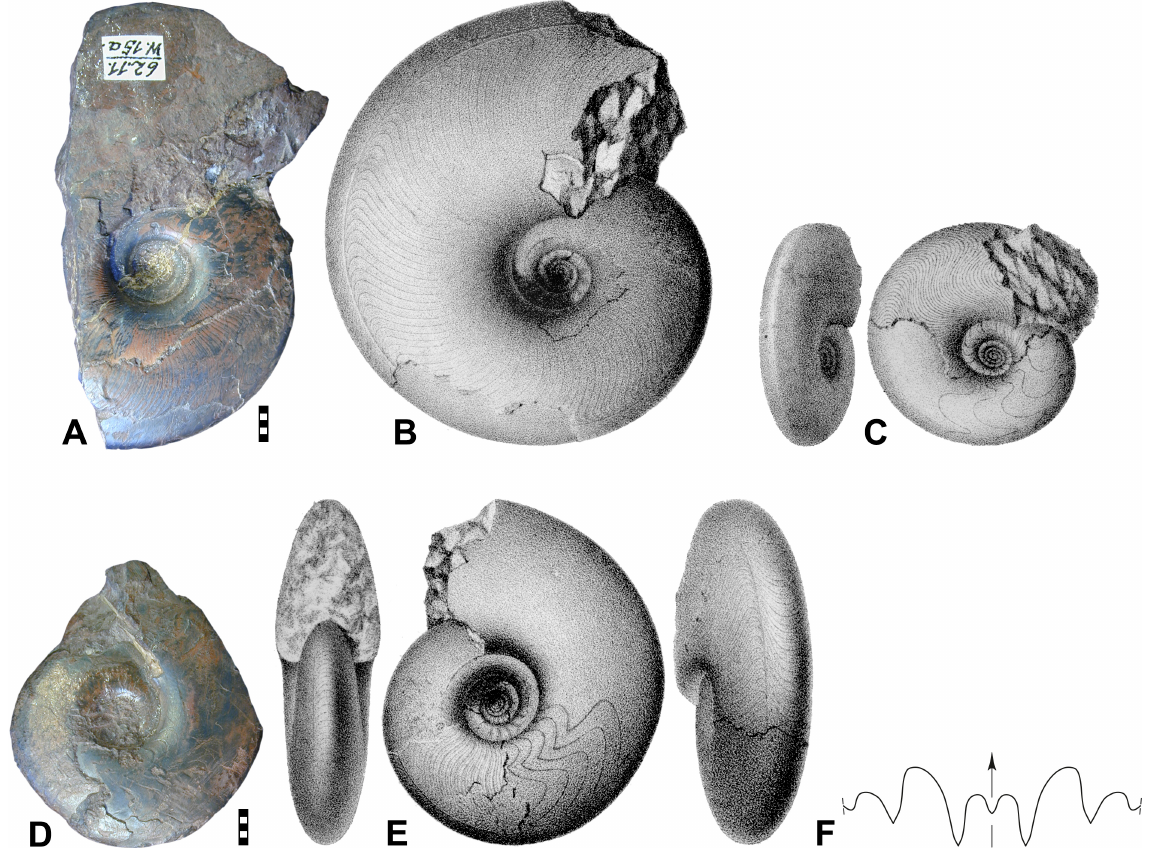
Fig. 16. Koenenites lamellosus (Sandberger & Sandberger, 1851). A . Lectotype 40a in the